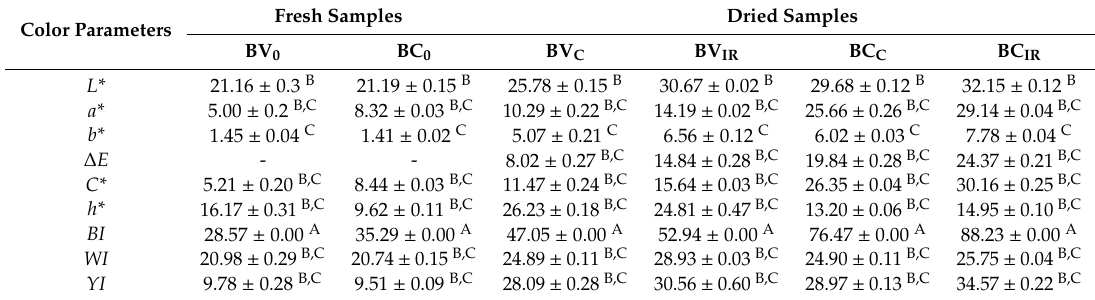
Table 2. E ff ects of drying treatment on color parameters of fresh and dried red beetroot pur é es. Fresh Color Parameters